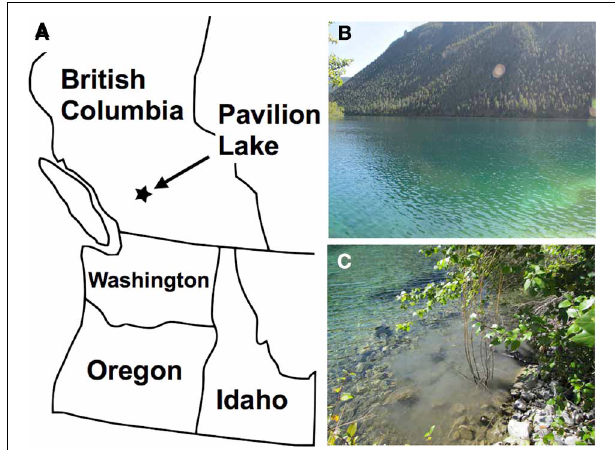
FIGURE 1 | Map showing the location of Pavilion Lake (A). Photograph taken in August 2011 showing a portion of Pavilion Lake (B) . The water and sediment samples that were used in this study were collected from the northern shore of the lake. (C) The disturbed sediment that was visible in the lake after collecting the sample from the